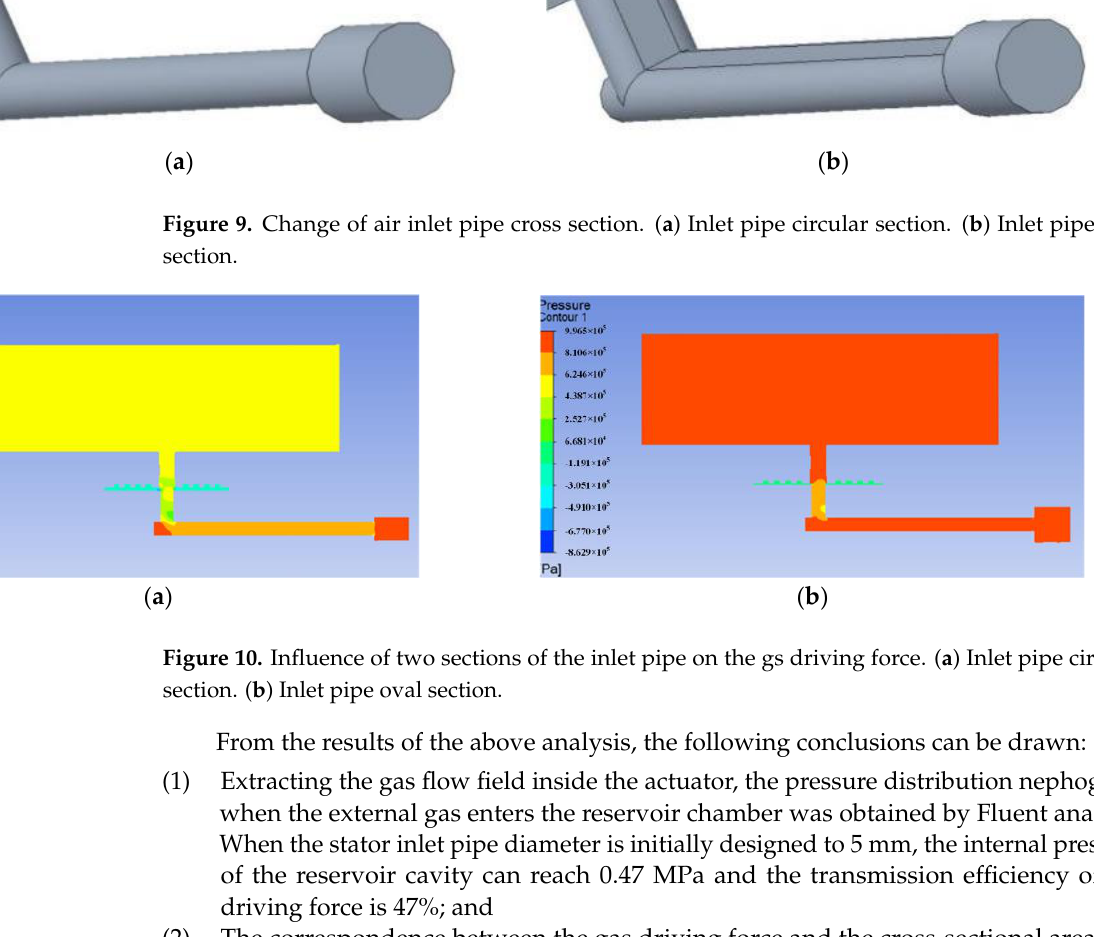
Figure 9. Change of air inlet pipe cross section. ( a ) Inlet pipe circular section. ( b ) Inlet pipe oval section.